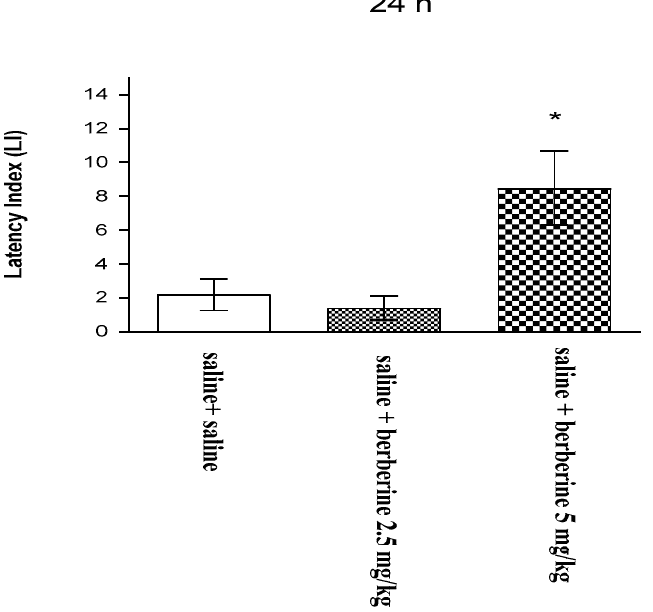
Figure 2. Effects of chronic berberine administration on the latency index (LI) during the memory acquisition trial with the PA test in mice. Berberine (2.5 or 5 mg/kg; i.p.) or saline was administered for 7 days. On the 8th day, 15 min after the last injection, the first trial was conducted. After 24 h, the mice were re-tested; n = 7–9; mean ± SEM; * p < 0.05 vs. saline-treated control group; Tukey’s test.